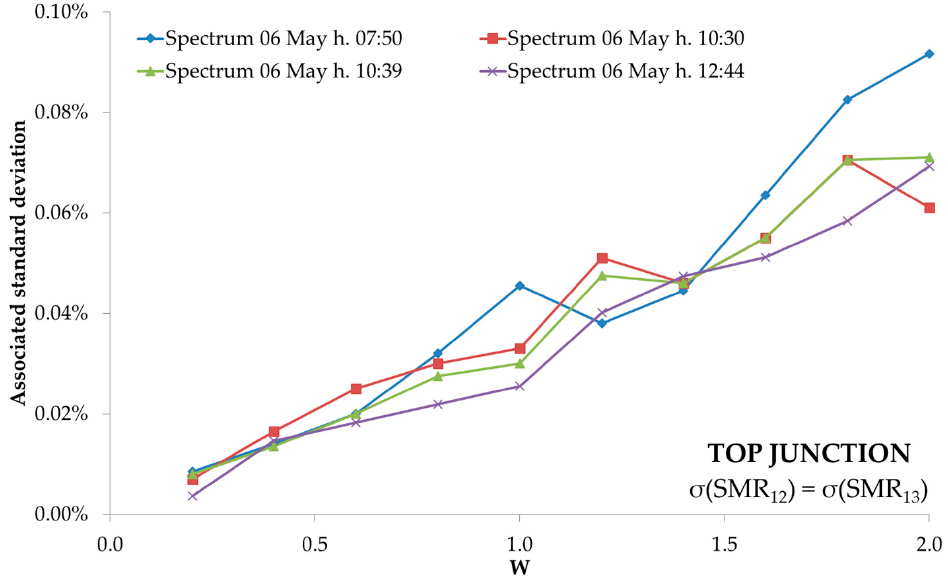
Figure 4. Impact of the errors on top junction spectral responsivity on SMR 12 and SMR 13 (k = 1). The slope of the functions indicates how much the output error is sensitive to an accurate estimation of the input errors on the top junction spectral response.